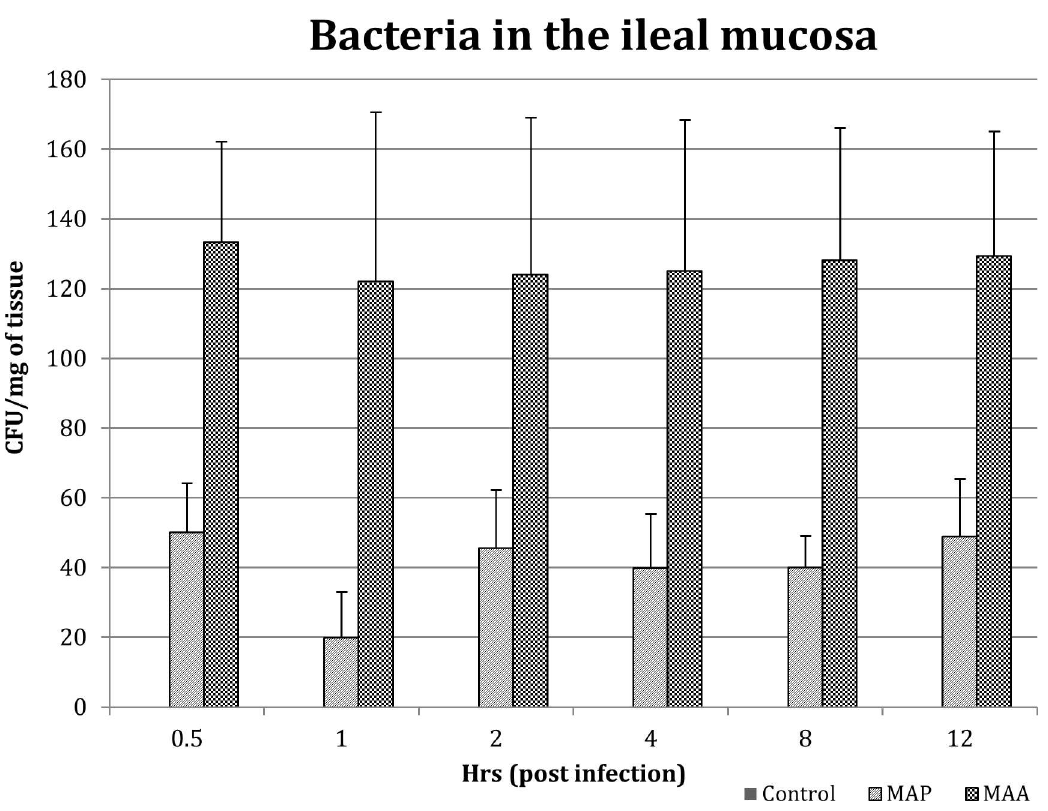
Fig 1. Invasion of Jejunaland Jejuno-ilealMucosaby MAP and